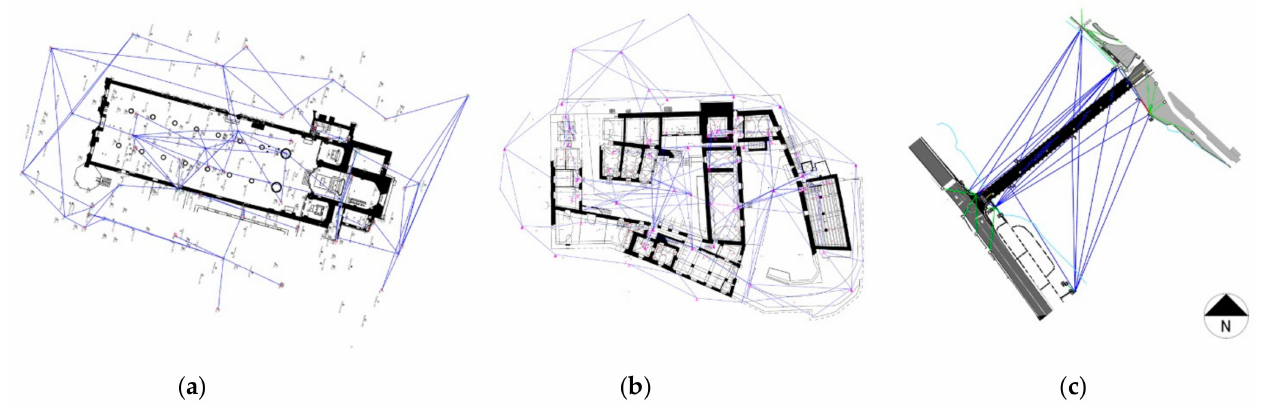
Figure 7. Geodetic networks of ( a ) Basilica di Collemaggio, ( b ) Masegra Castle and ( c ) Visconti